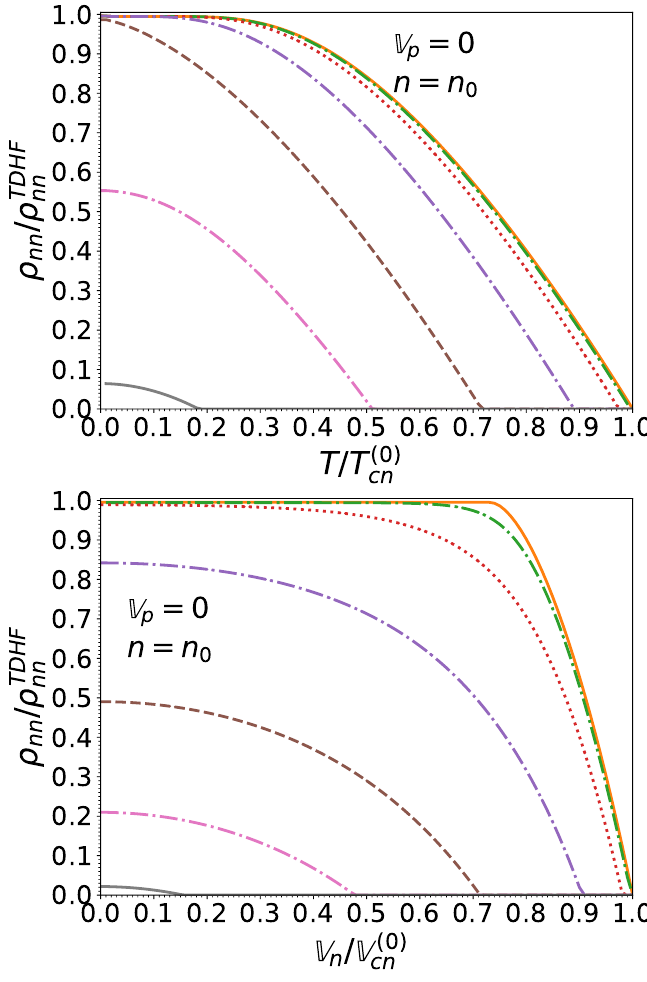
Figure 15. Same as Figure 12 at the saturation density n 0 using the same notation for the meaning of the different curves.